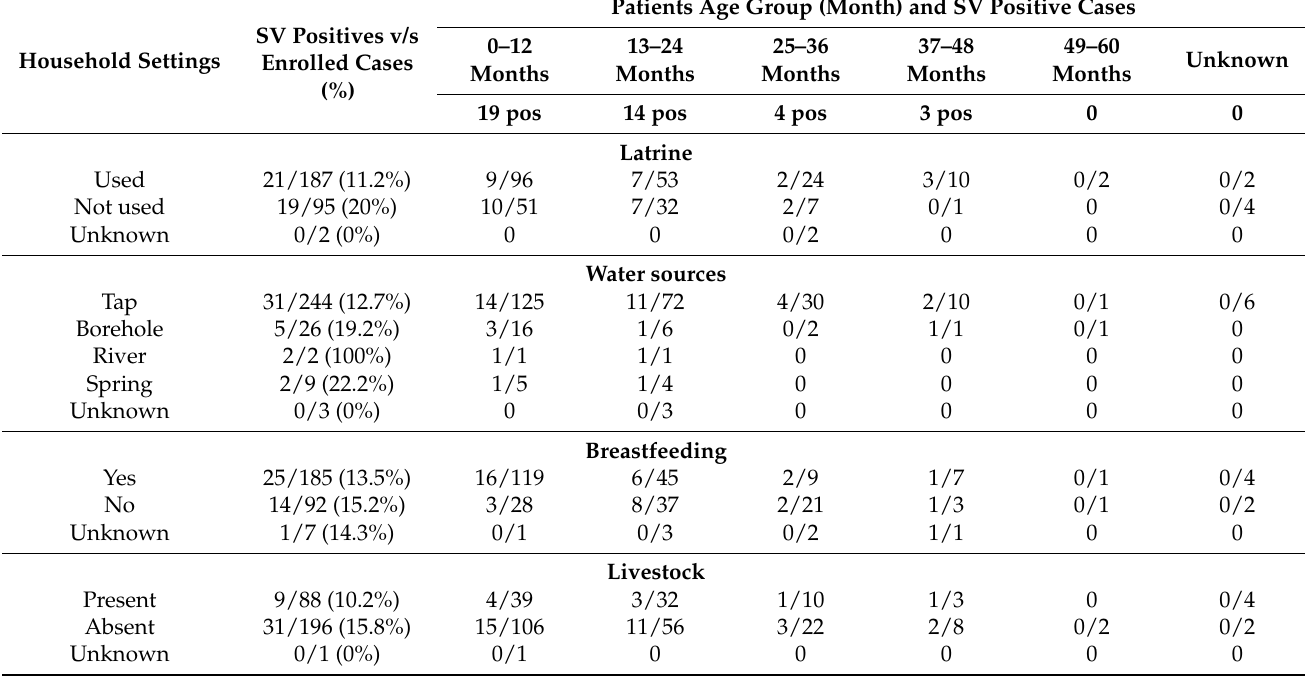
Table 4. Household settings of the participants and distribution of sapovirus (SV) positive